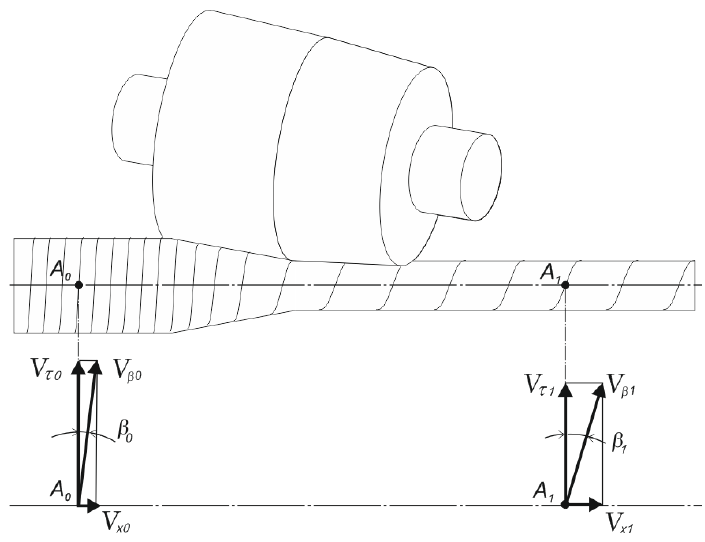
Figure 3. The trajectory – speed scheme of metal flow during the